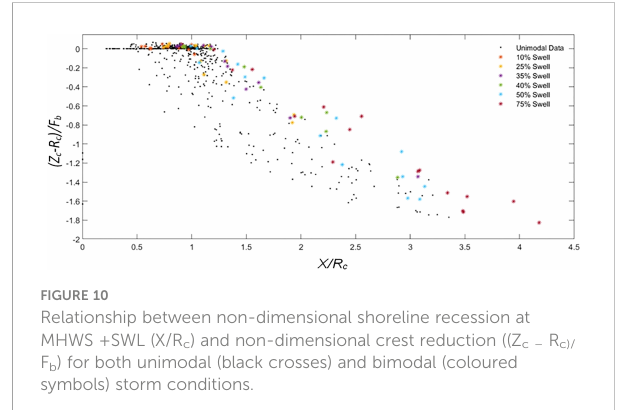
FIGURE 10 Relationship between non-dimensional shoreline recession at MHWS +SWL (X/R c ) and non-dimensional crest reduction ((Z c – R c)/ F b ) for both unimodal (black crosses) and bimodal (coloured symbols) storm conditions.